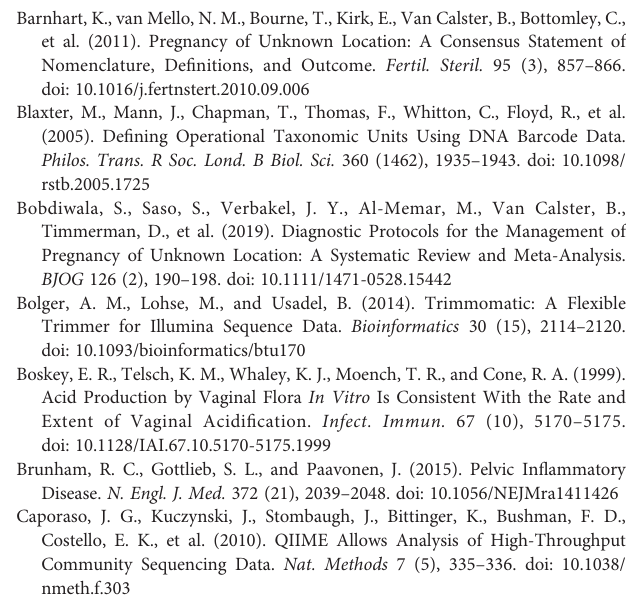
Supplementary Figure S1 | Alpha diversity comparison of the TP and IUP groups. (A) Alpha diversity measures of the Simpson index, which responds to richnessofthesamples. (B) ShannonIndexwasusedtocomparealphadiversityfor evenness of these samples. Supplementary Figure S2 | PCoA analysis of vaginal microbiota between IUP and TP women. (A) PCoA analysis based on Bray Curtis distance of the IUP and TP group data. (B) PCoA analysis based on weighted Unifrac distance of the IUP and TP group